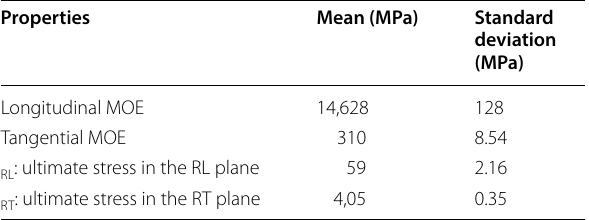
Table 3 Results of tensile tests (of wood plies) longitudinal and perpendicular to fibers